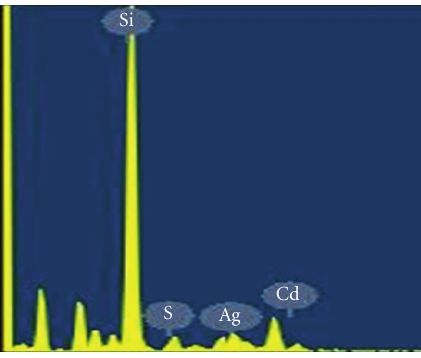
Figure 3: EDAX spectra obtained from as grown Ag doped nanostructured CdS thin films prepared by cost e ff ective chemical route at room